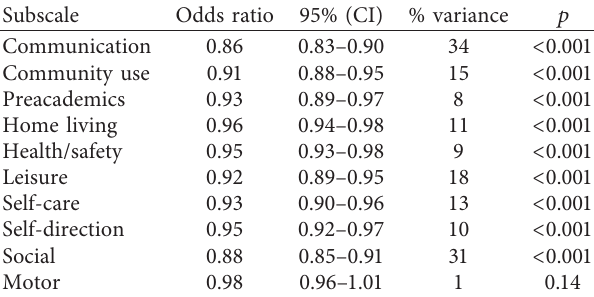
Table 4: Predicting ASD diagnosis based on adaptive behavior subscale raw scores.